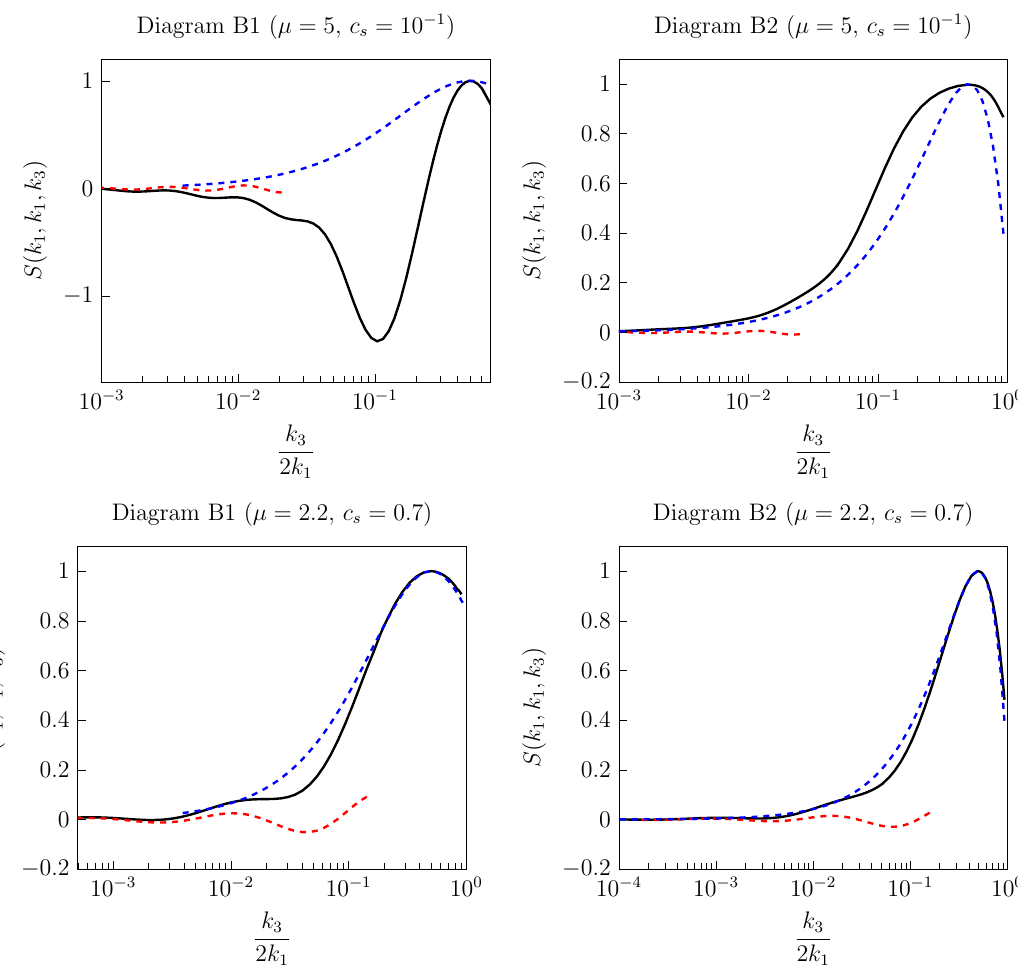
Figure 12 . Shapes S ( k 1 , k 1 , k 3 ) of the bispectra for isosceles triangles, normalized to unity in equilateral configurations, for diagrams B1 (left) and B2 (right), and for ( µ = 5 , c and ( µ = 2 . 2 , c = 0 . 7) (bottom). The dashed red and blue curves represent respectively the s ultra-squeezed signal (5.12) and the one that would result from the local EFT after integrating out the heavy